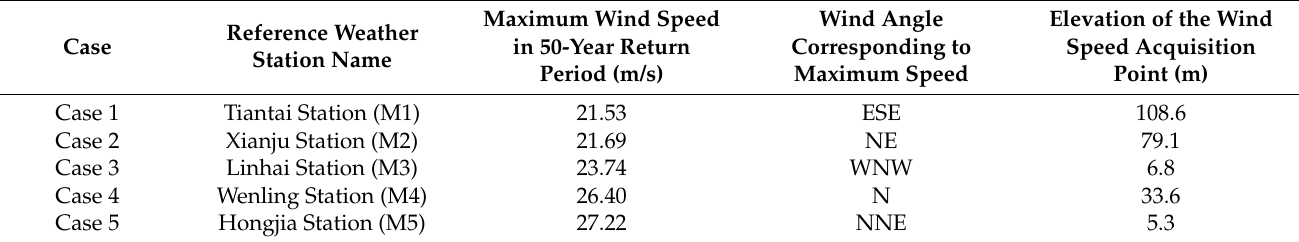
Table 7. The cases of CFD